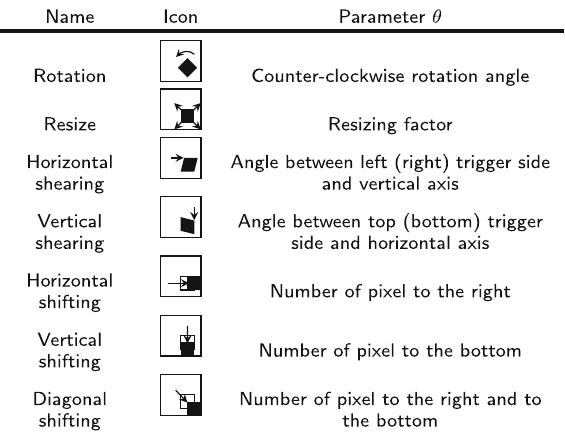
Figure 3 visualizes the process applied to create (cid:2) λ ( x , φ θ ( s )) for each clean image x . The pipeline adopted from [10] stores the test images (cid:2)( X , φ θ ( s )) in JPEG format with default quality factor 75.